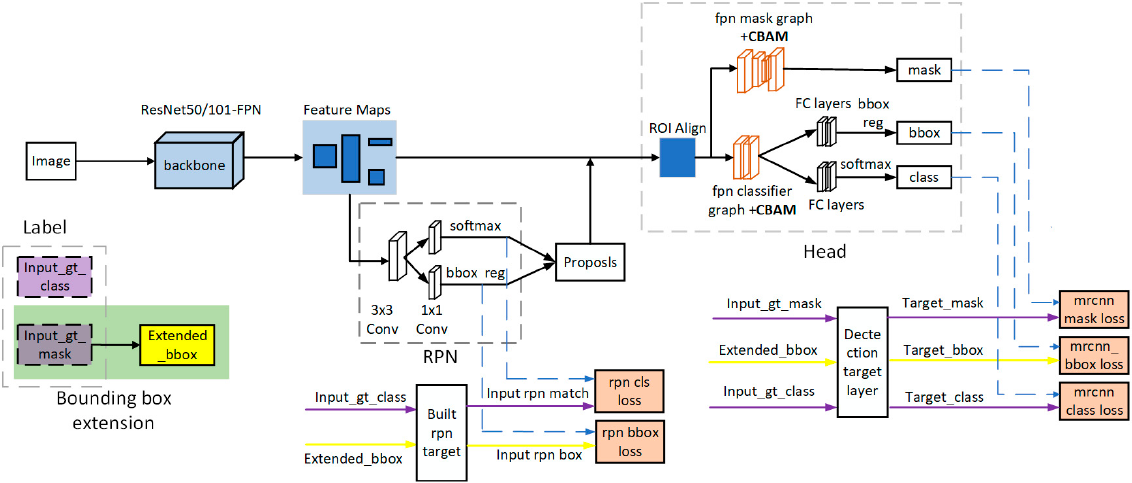
Figure 2. Network structure of the improved Mask R-CNN.